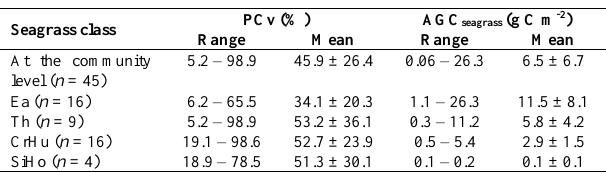
Table 2. PCv and AGC measurement results for each class of the harvested seagrass ( n is the number of